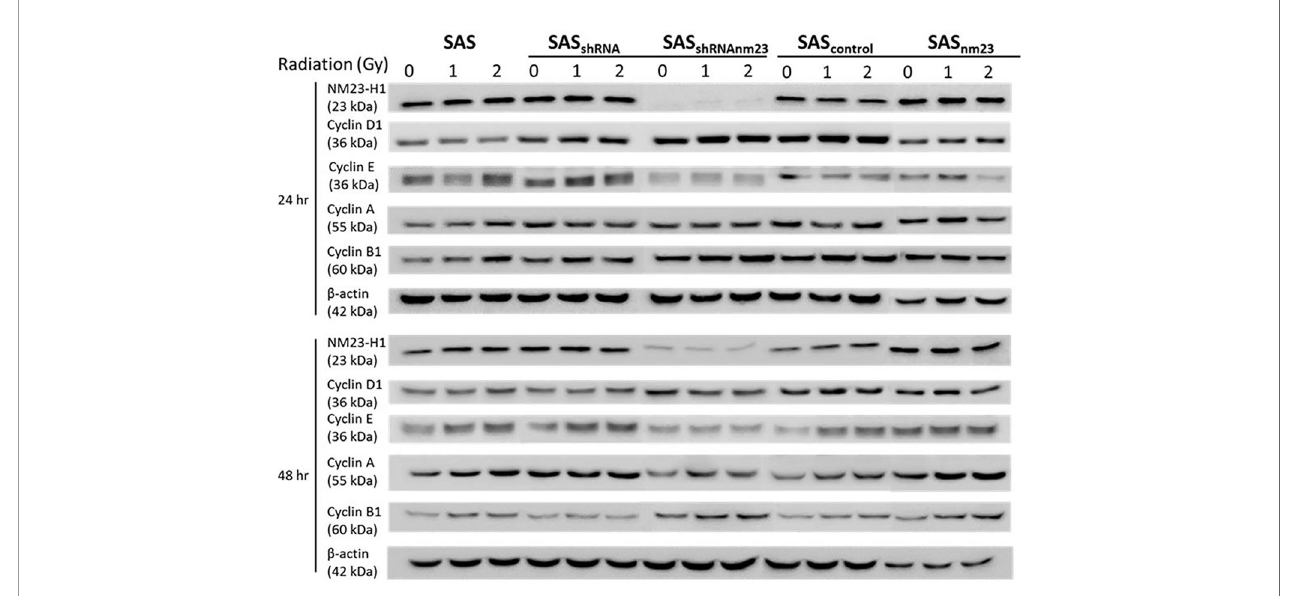
FIGURE 4 | Western blot showing the effect of NM23-H1 expression on cyclin D1, E, A1, and B1 after SAS cells treated by irradiation. Following irradiation at graded doses of 0, 1 and 2 Gy, cells were collected, lysed, and analyzed by Western blot for SAS clones, including parental (SAS), mock knockdown (SAS shRNA ), NM23-H1 knockdown (SAS shRNAnm23 ), mock overexpression (SAS control ), and NM23-H1 overexpression (SAS nm23 )